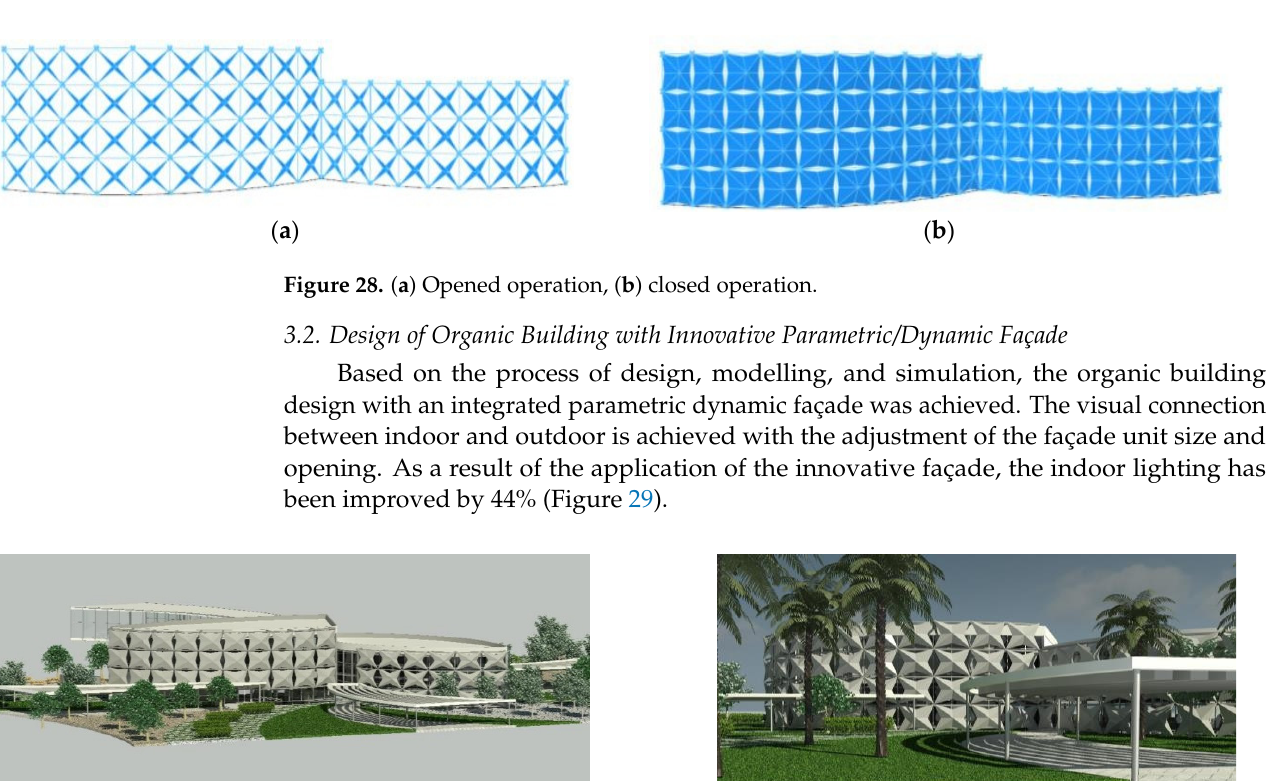
Figure 29. Modules of dynamic façade with different phases of movement.